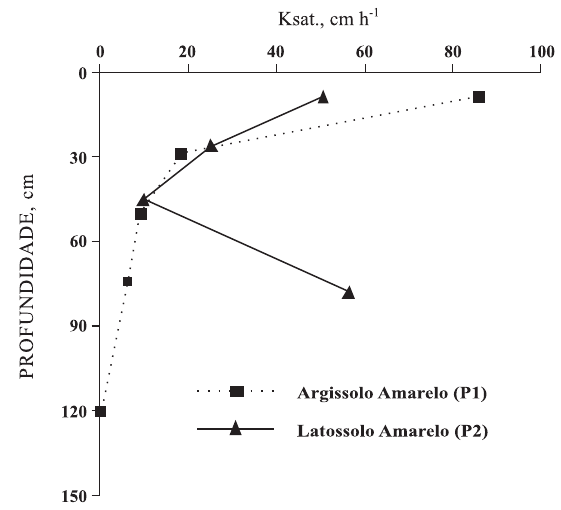
Figura 2. Condutividade hidráulica saturada (K em Argissolo Amarelo (PA) e Latossolo Amarelo (LA1) dos tabuleiros costeiros de Alagoas, sob mata